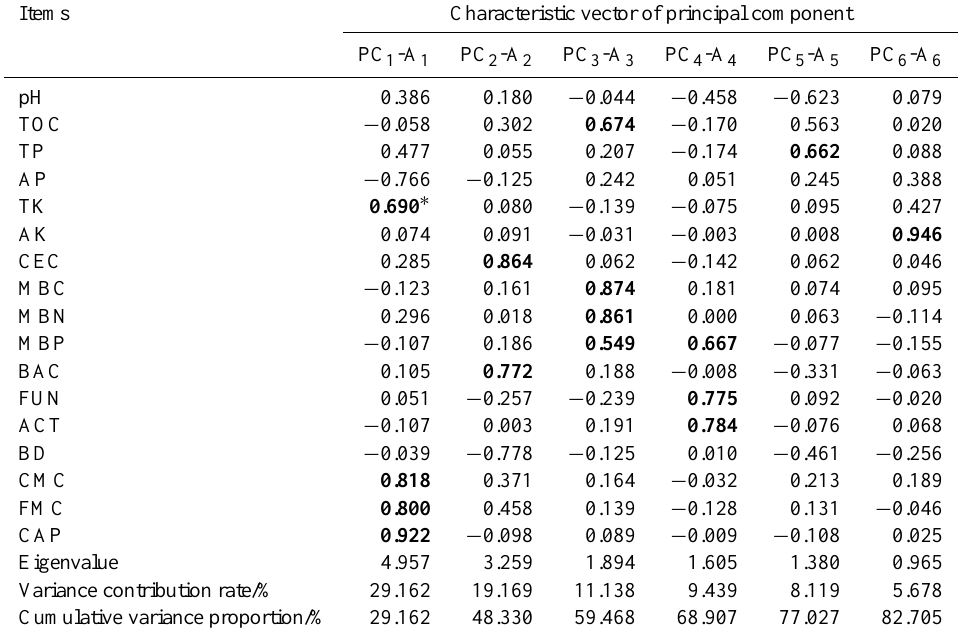
Table 4. Principal components analysis. Items